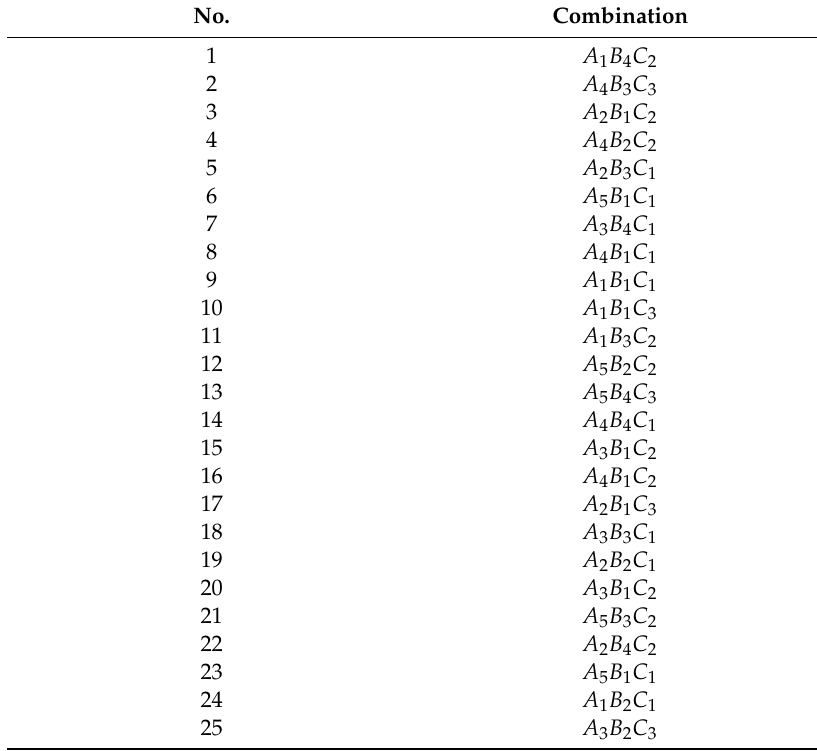
Table 2. Orthogonal table for optimization of the tubular